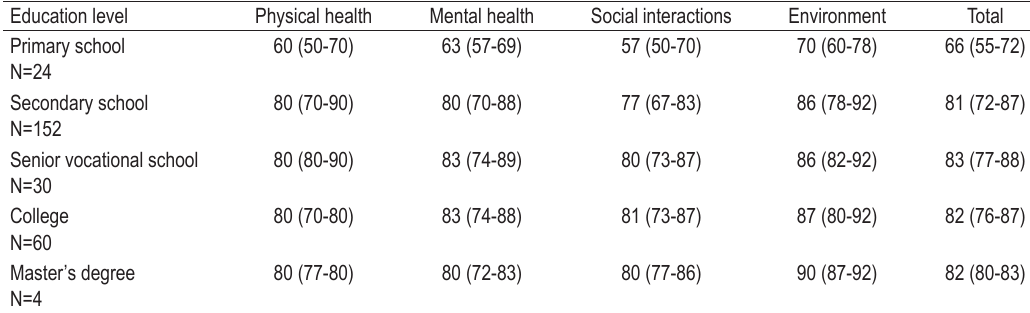
TABLE 1. Subjective perception of quality of live according to the education level of participants